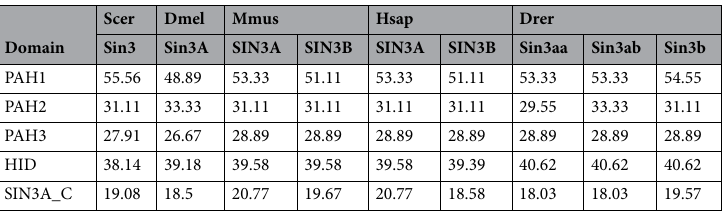
Table 2. Conservation of SIN-3 protein domains of C. elegans with those of other organisms expressed in percent similarity. Scer ( Saccharomyces cerevisiae ), Dmel ( Drosophila melanogaster ), Mmus ( Mus musculus ), Hsap ( Homo sapiens ), Drer ( Danio rerio ). Caenorhabditis elegans SIN-3 protein consists of a single PAH